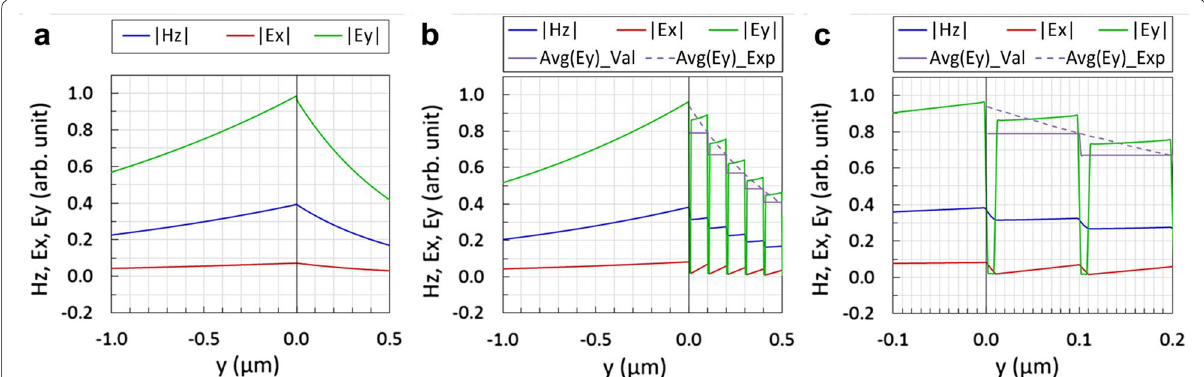
Fig. 6 FDTD analysis of field distributions ( H z , E y , and E x ) in a hyperbolic metamaterial/dielectric structure. The metamaterial side ( y > 0) consists of Ag(10 nm)/SiO 2 (90 nm) alternating multilayers. a A homogeneous anisotropic dielectric tensor, calculated by an effective medium approximation, is assumed for the metamaterial part. b Isotropic dielectric constants of bulk Ag and SiO 2 are assumed for the multilayer structure. c A close-up view of panel ( b ) near the interface ( y 0). Note that normal E -field ( E y : green) is well suppressed in metal layers while remaining strong in dielectric = layers. Also note that tangential E -field ( E x ) remains low, implying that this surface-bound wave becomes more transverse-electromagnetic than